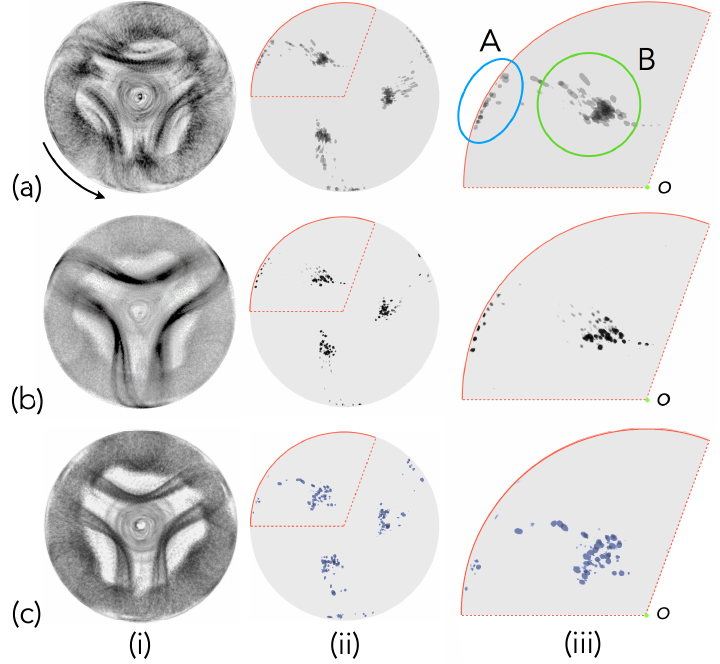
Figure 7. PASs observed through the top rod in a rotating frame of reference under Ma = ( a ) 4.1 × 10 4 , ( b ) 4.7 × 10 4 , and ( c ) 5.2 × 10 4 in a liquid bridge of Pr = 28.5, Γ = 0.68 ( R = 2.5mm), and V / V 0 = 1.0 with suspended particles 30µm in diameter: Columns ( i , ii ) indicate the projected images, and Poincaré sections at midheight of the liquid bridge, respectively. Images for column ( i ) are obtained by by integrating 500 frames (for about 8.3s). Images for ( ii )-( a ) and -( b ) are obtained by integrating 3900 frames (for almost 65s), and -( c ) 2340 frames (for almost 39s). Column ( iii ) shows a zoomed view of the 1/3 = 1/ m 0 region of the image in ( ii ). The fundamental frequencies ( HTW ) f are ( a ) 1.41Hz, ( b ) 1.42Hz, and ( c ) 1.44Hz. The rotating direction of the HTW in this figure 0 is counter-clockwise in the laboratory frame. Ma is evaluated by applying H for the characteristic length L . ( Figure 2 in Yamaguchi et al.